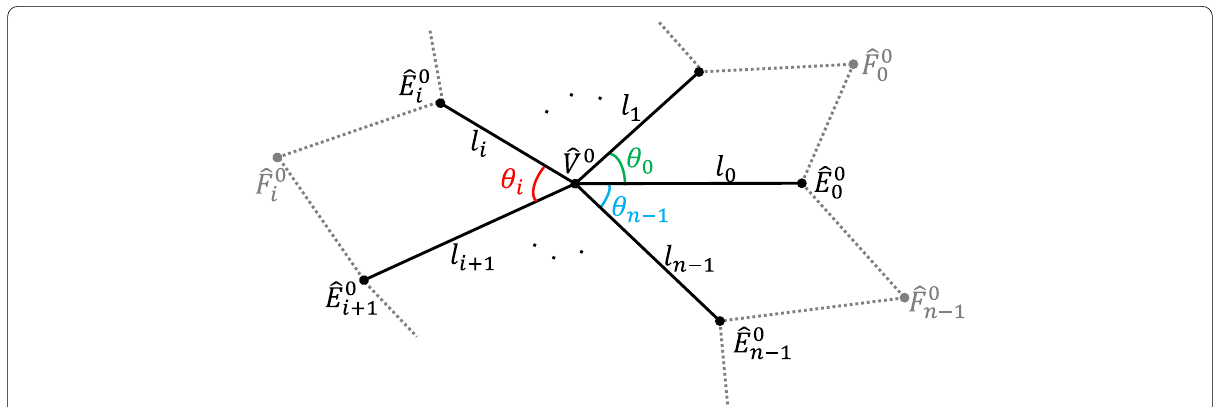
Fig. 3 Notations for an eigen-polyhedron ˆ P 0 for an EP, where ˆ V 0 is (0, 0), l i are the lengths of edges ˆ V 0 ˆ E 0 i , and θ i are the angles between ˆ V 0 ˆ E 0 i and ˆ P 0 are determined by l ˆ E 0 ˆ V 0 ˆ E 0 i in i + 1 . The edge points i and θ